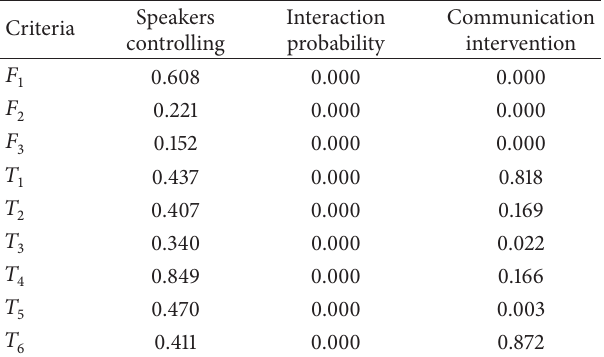
Table 4: Statistical significance for the three